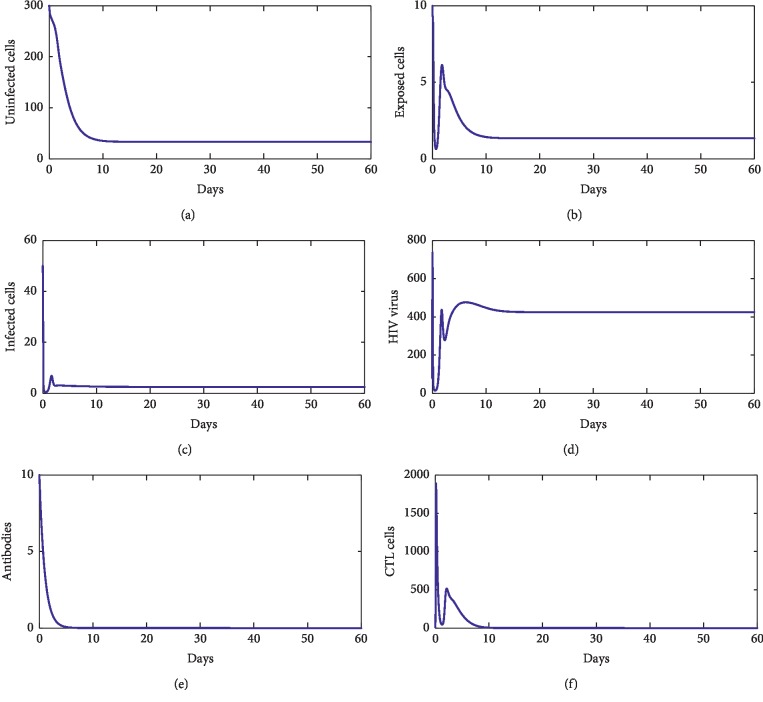
The behavior of the disease for λ=2, d1=0.0139, k1=0.05, d2=0.0495, k2=1.1, d3=0.5776, a=100, d4=0.6, q=0.05, g=10−11, h=0.1, p=0.0024, c=0.15, and b=0.5.